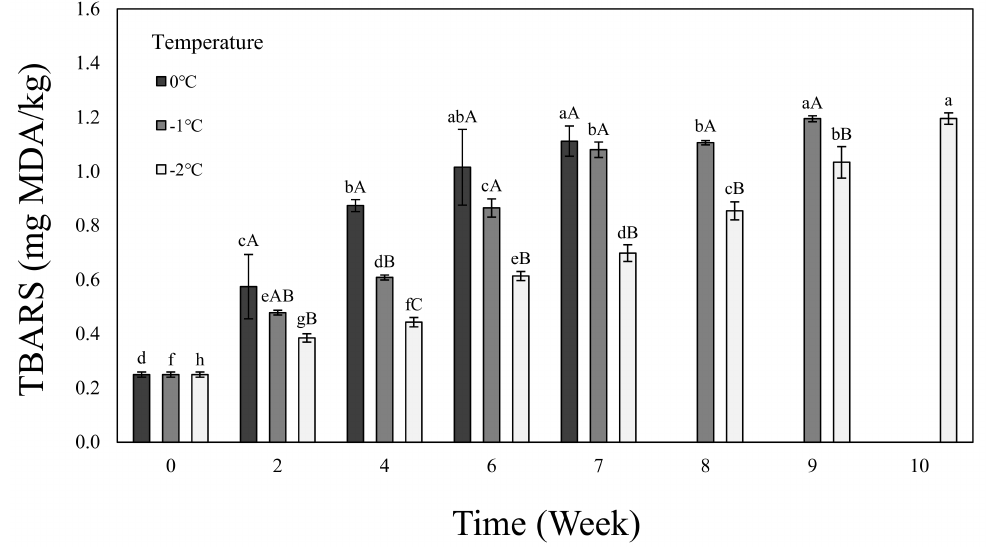
Figure 2. TBARS of dry-aged beef loin on 0, − 1, − 2 ◦ C temperature electric field refrigerate sys- tem. a–h Means in the same temperature with different letters are significantly different ( p < 0.05). A–C Means in the same time with different letters are significantly different ( p < 0.05). Samples were measured until aging stopped as the value of TPC reached 7 log